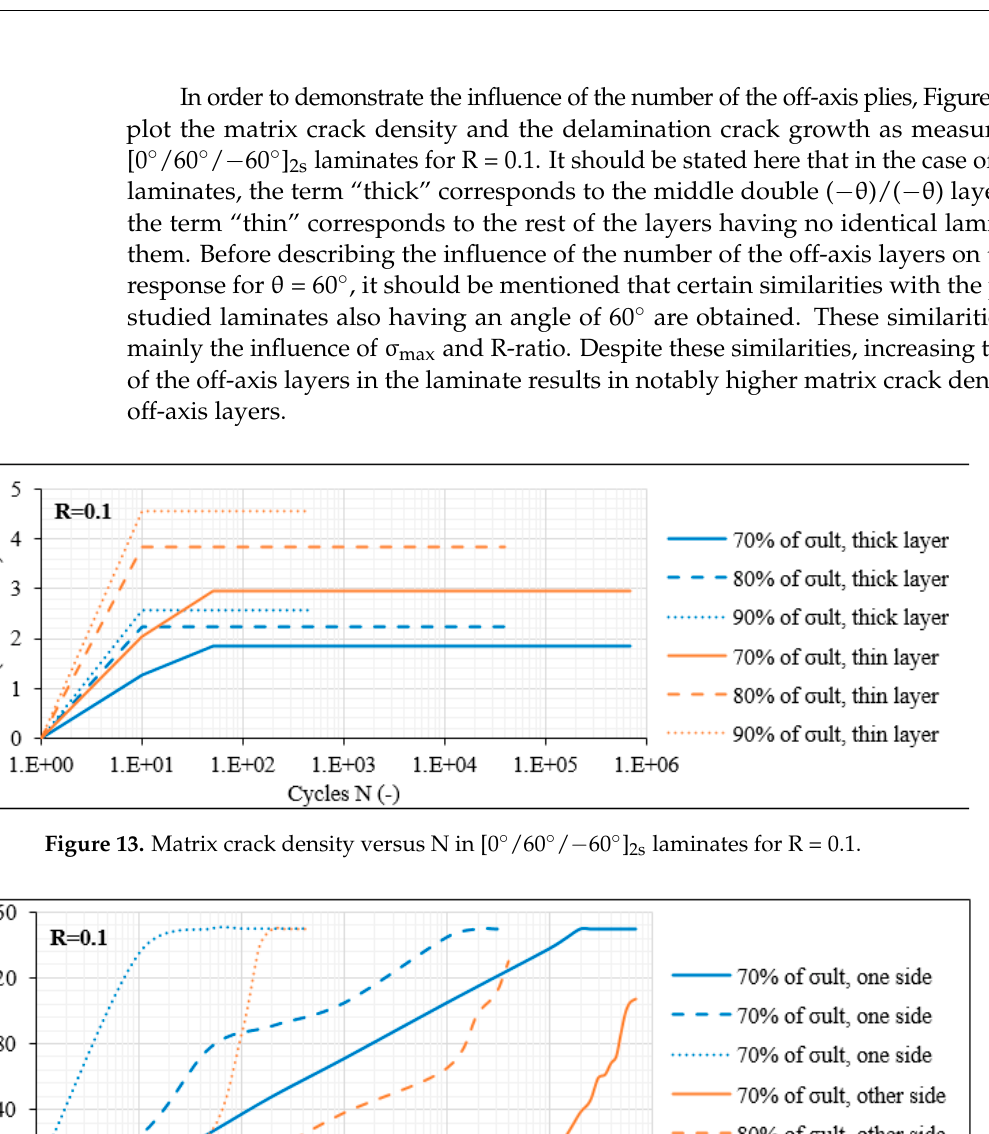
Figure 11. Matrix crack density versus N in [0°/60°/0°/ − 60°] s laminates for R = 0.1.